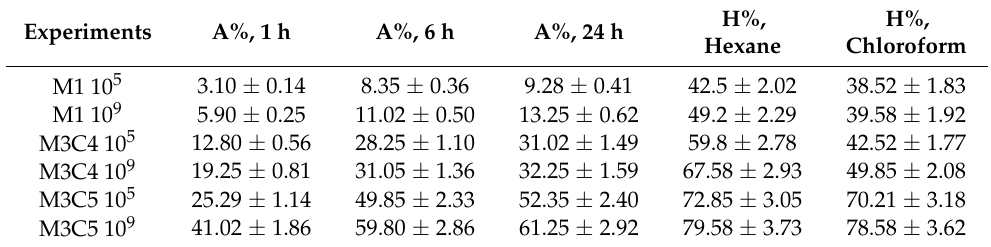
Table 6. Hydrophobicity and auto-aggregation rate of the tested samples.